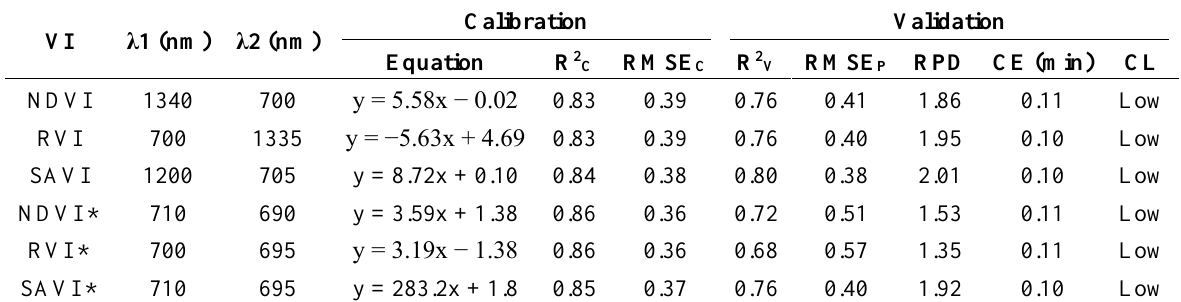
Table 4. The best-performing LNC models based on the vegetation indices (VIs) for the calibration and validation sets.